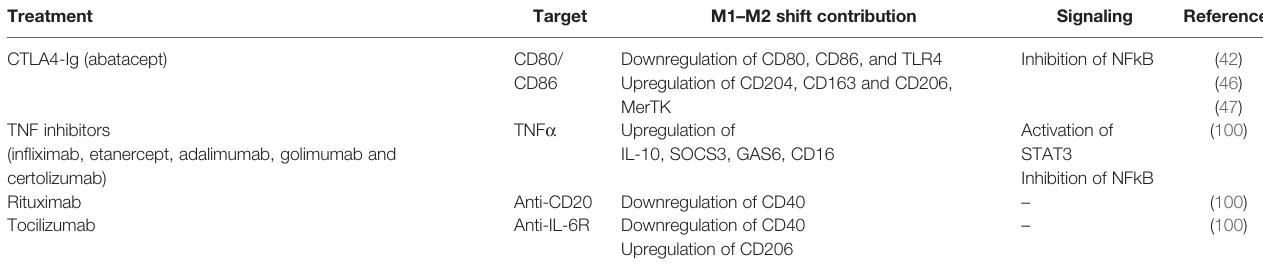
TABLE 1 | Targets, effect, and signaling pathways of biological disease-modifying anti-rheumatic drugs (bDMARDs).